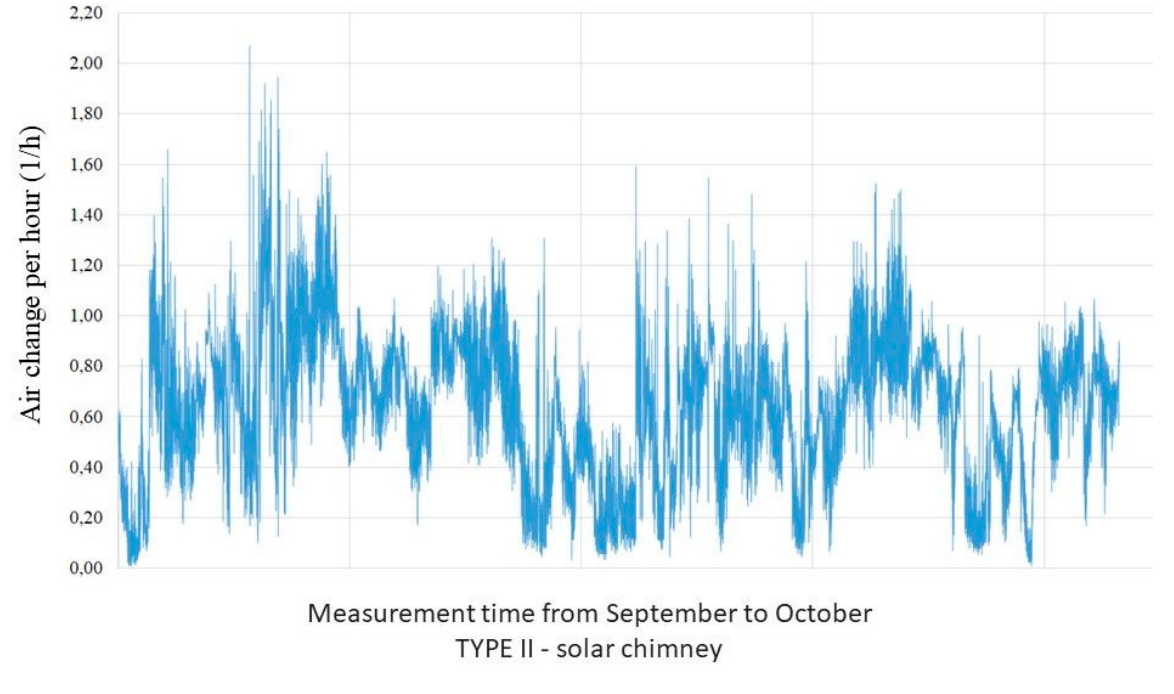
Figure 15. Gravity ventilation efficiency—solar chimney TYPE II.